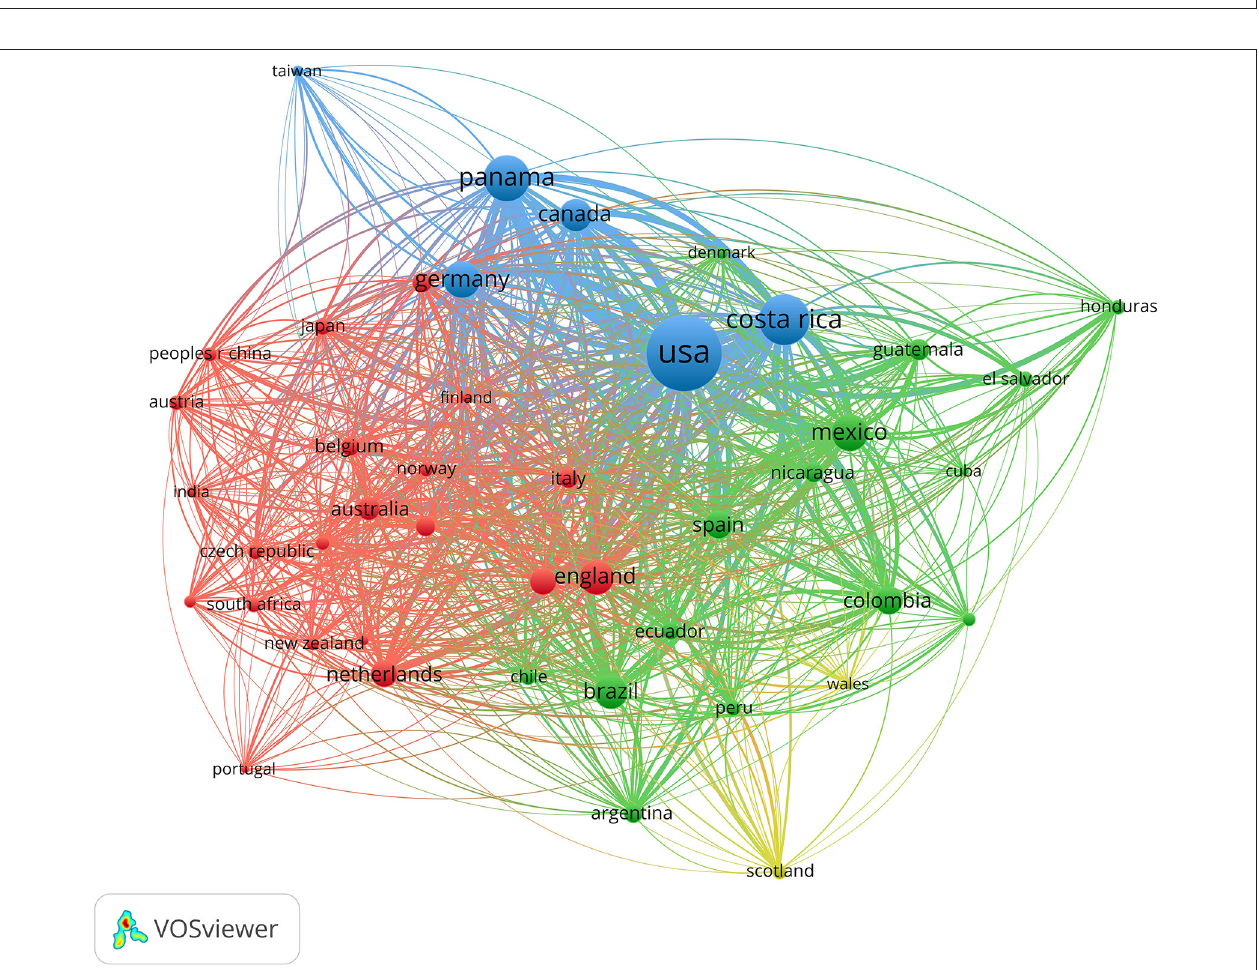
FIGURE 2 | Network visualization map of international research collaboration among top active countries in biodiversity research in Central America. A threshold of at least 30 co-authored publications was applied. The size of the node and connecting line is proportional to the influence of the node in the network (number of publications and collaborations). Color indicates the relatedness of each cluster (by VOSviewer